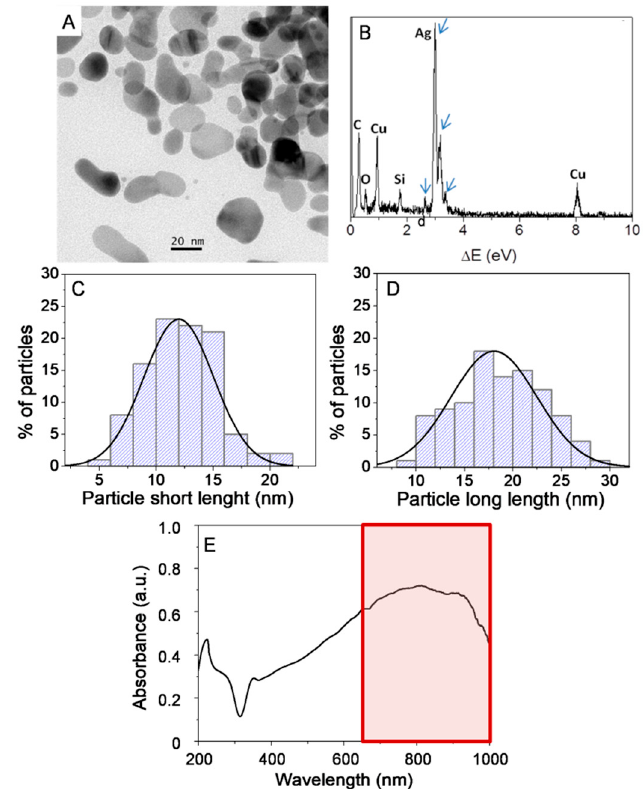
Figure 1. Microstructural characterization of AgNPs by TEM ( A ), EDX analysis of AgNPs ( B ), in which arrows indicate silver peaks. Particles short-length ( C ) and long-length ( D ) histograms-based on the measurements of over 150 nanoparticles. UV-Vis spectrum of AgNPs in solution ( E ) showing a maximum absorption in the NIR region (650–1350 nm in a red box). Signals from the elements Si, Cu and C are originated from carbon-coated copper TEM grid.